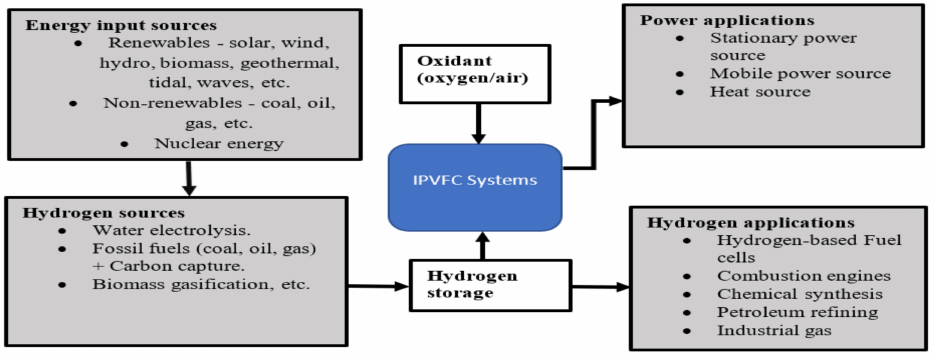
Figure 6. Energy inputs, materials, and applications of IPVFC systems in a hydrogen